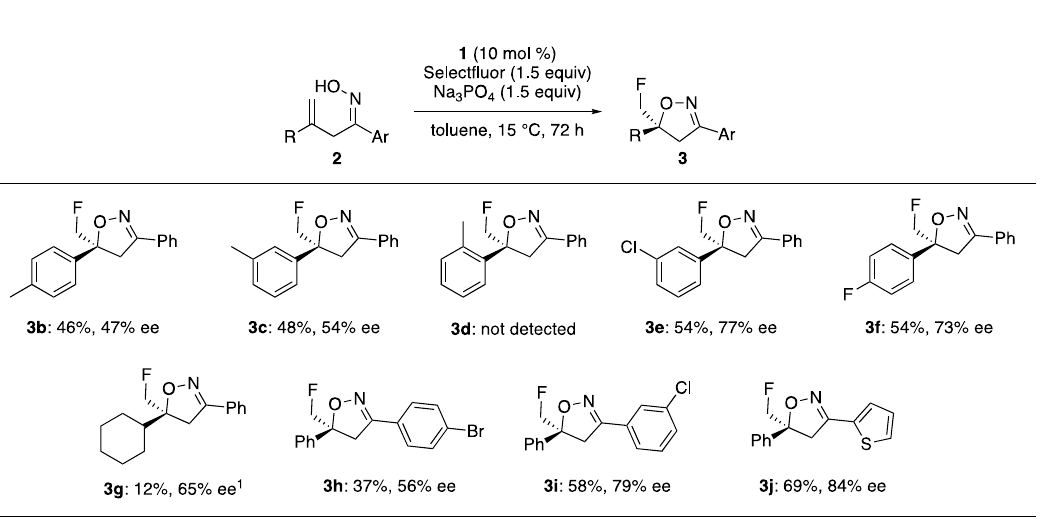
Figure 1. Fluorocyclization of ene-oximes.